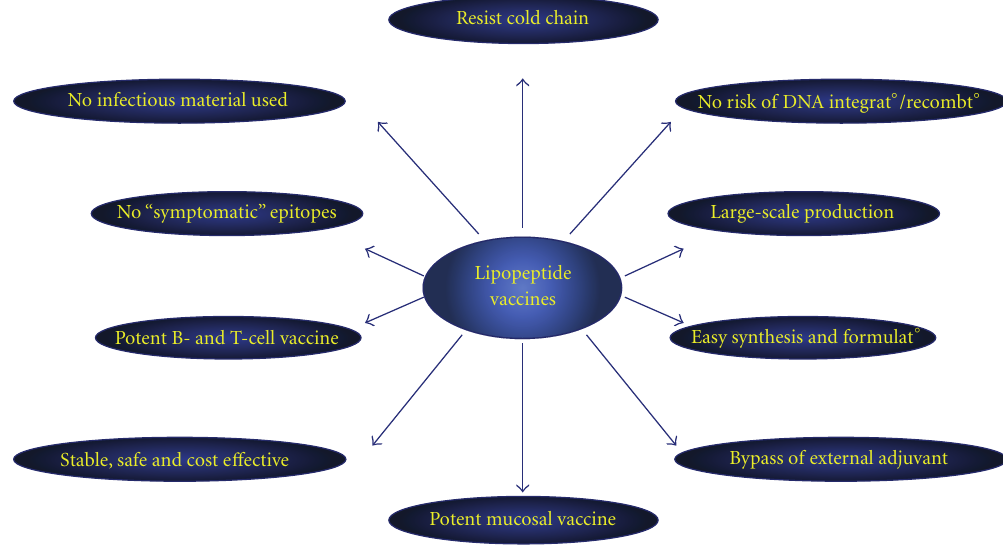
Figure 3: A representative diagram showing the advantages of lipopeptide-based vaccines strategy, as elaborated in the text (see Section 6).